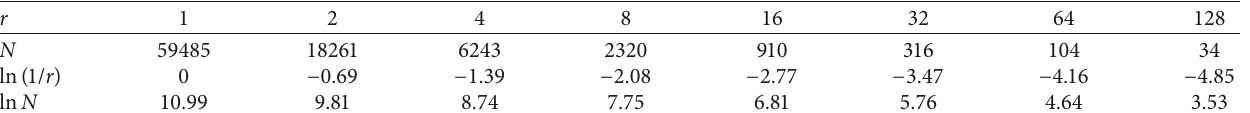
Table 9: List for calculating D